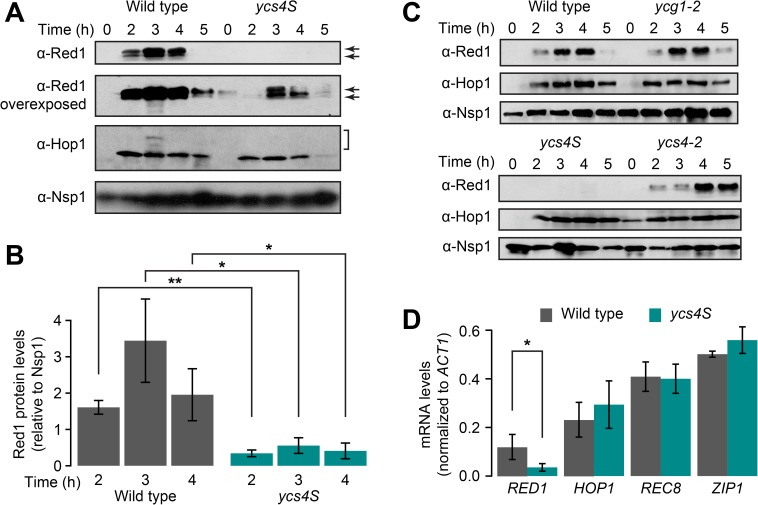
ycs4S mutants have decreased levels of Red1.(A) Red1 and Hop1 protein levels of whole-cell extracts from wild type (H7797) and ycs4S (H7011) as determined by western blotting at the indicated time points after meiotic induction. Arrows indicate the two Red1 bands. Bracket indicates positions of phosphorylated Hop1. Nsp1 was used as loading control. (B) Fluorescence-based quantitative measurement of total Red1 protein levels in wild type and ycs4S relative to Nsp1 at 2h, 3h, and 4h, n = 3. Error bars: S.E.M. *: p-value < 0.05, **: p-value < 0.005, paired Student t-test. (C) Western analysis of Red1 and Hop1 protein levels in wild-type, ycg1-2 (H8632), ycs4S, and ycs4-2 (H8601) strains. Nsp1 was used as loading control. ycg1-2 and ycs4-2 cultures were shifted to 34°C 1 hour after meiotic induction. (D)
RED1, HOP1, REC8, and ZIP1 mRNA levels at 2h were measured by RT-qPCR from both wild-type (grey) and ycs4S (cyan) extracts, and normalized against ACT1, n = 3. Error bars: S.D. *: p-value < 0.05, Student t-test.